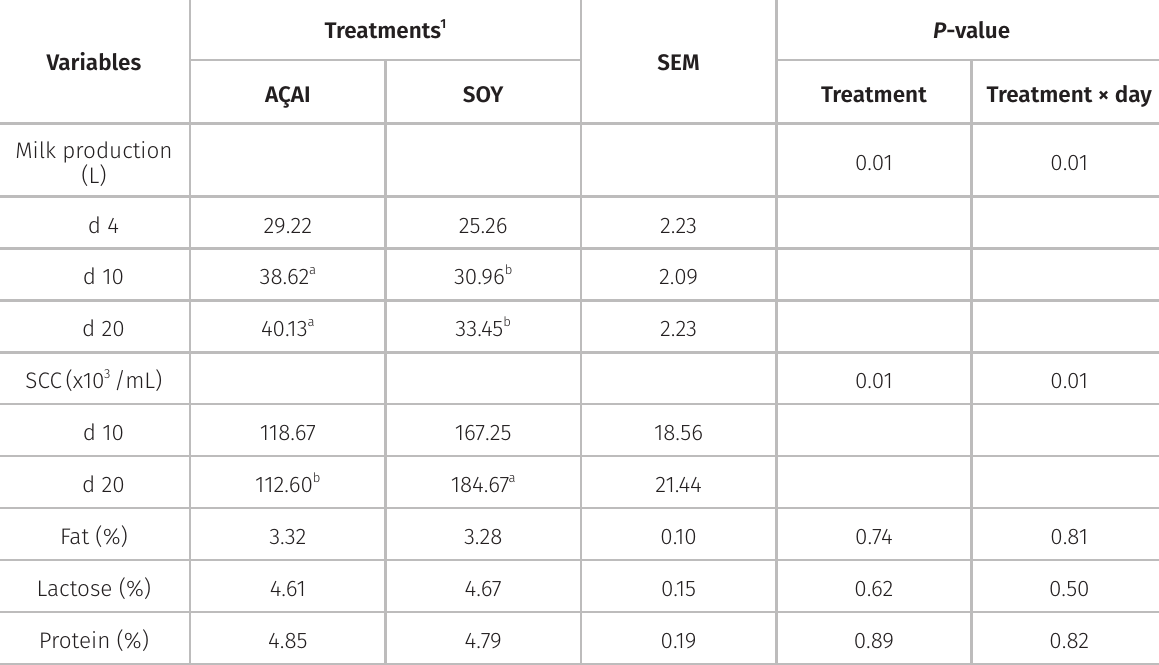
Table II. Milk production, somatic cell count (SCC), fat, lactose and protein of cows fed with açai oil or soybean oil during the prepartum period: Assessments made within the transition period (4, 10 and 20 days